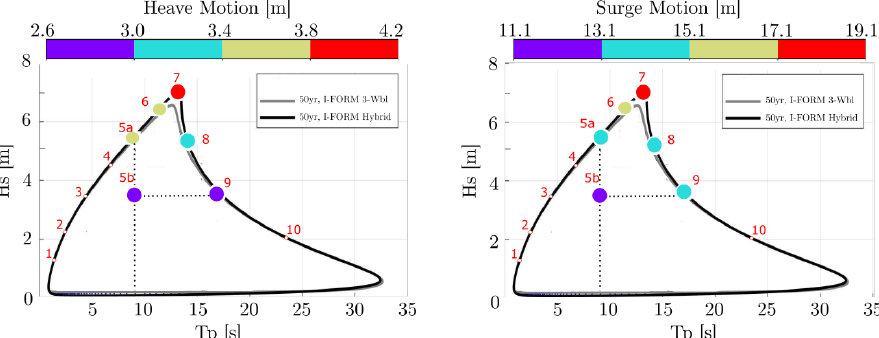
Figure 14. Colormap visualization of the maximum heave response range ( left ) and maximum surge response range ( right ) along the environmental contour line.